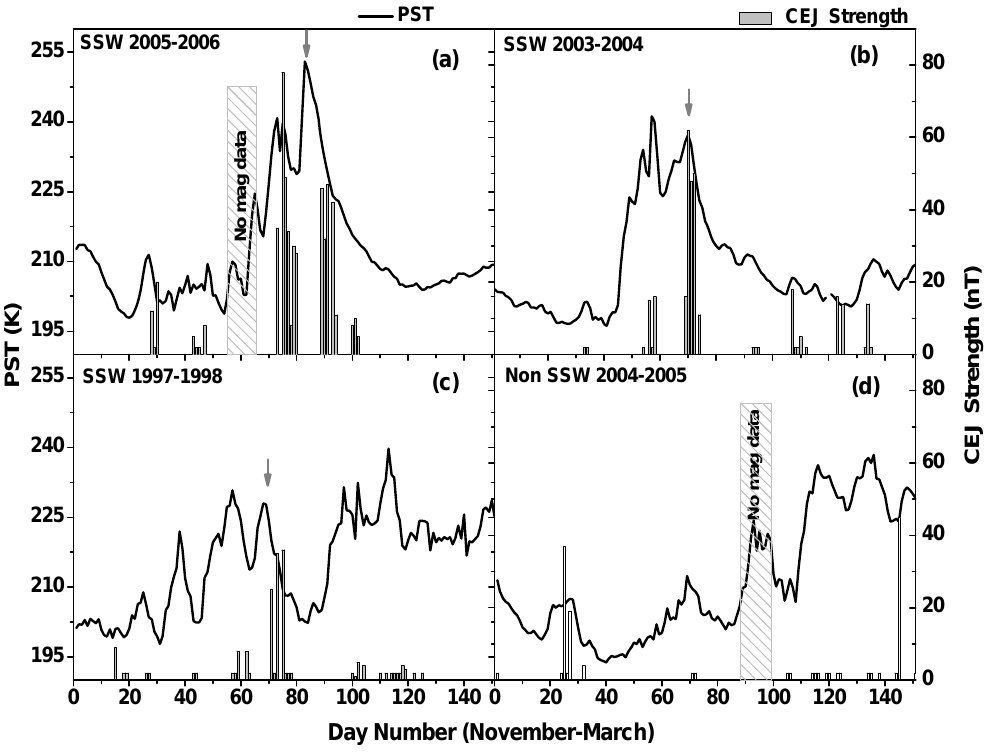
Fig. 1. Daily variation (1 November–31 March) of polar stratospheric temperature (at 10hPa) and the CEJ strength during the SSW years (a) (2005–2006), (b) (2003–2004) (c) (1997–1998) and a non-SSW year (d) (2004–2005). The central date of the major SSW is marked in each plot using vertical